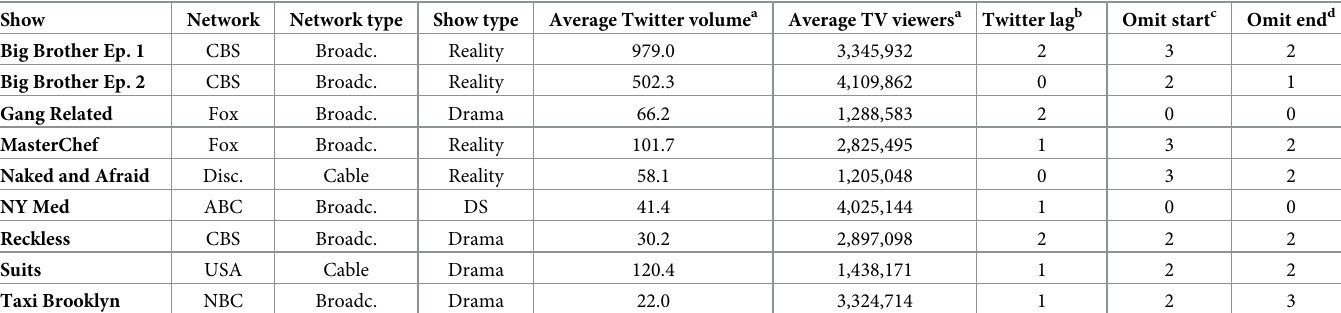
Table 1. TV episode information and pre-processing